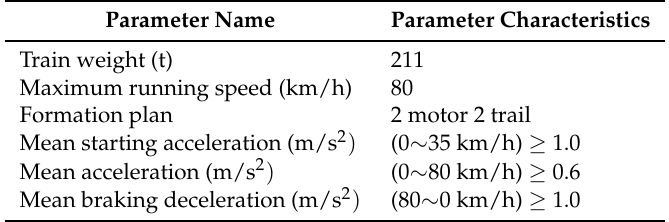
Table 3. The main parameters of the scenario about rail transit line No.12 in